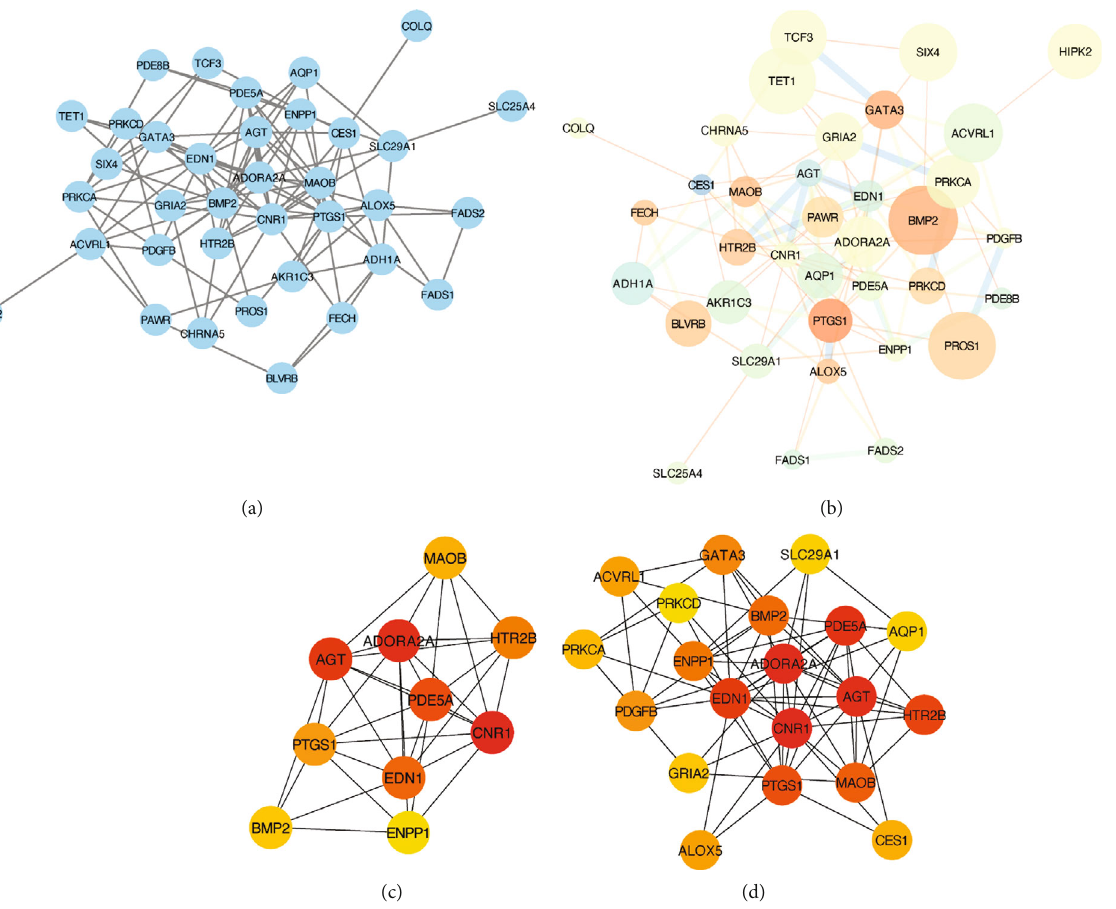
Figure 6: Protein – protein interaction (PPI) network of gestational diabetes mellitus (GDM) target genes. (a) PPI network, (b) network analyzer network, (c) top 10 hub genes, and (d) top 20 hub genes. The size of the circle represents the signi fi cance. From blue to red represents the di ff erent log fold change, the thickness of the connection represents the combined score. 2 Table 2: Top 10 hub genes according to the Matthews correlation coe ffi cient